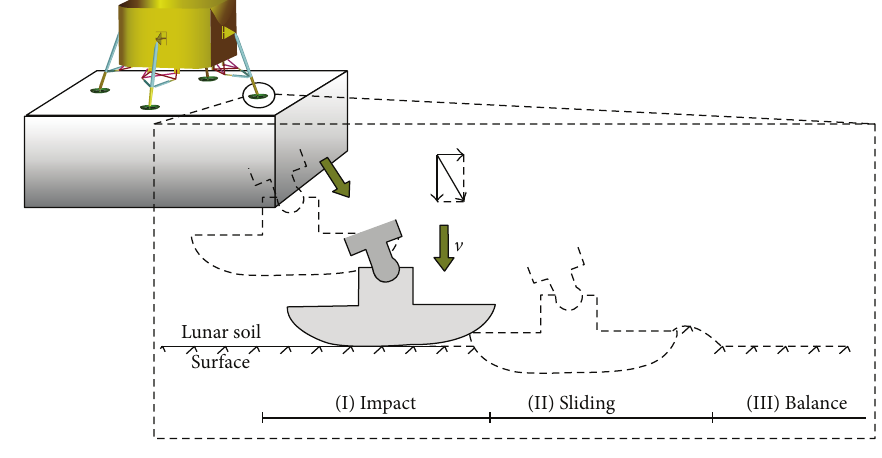
Figure 3: Landing process of footpad.